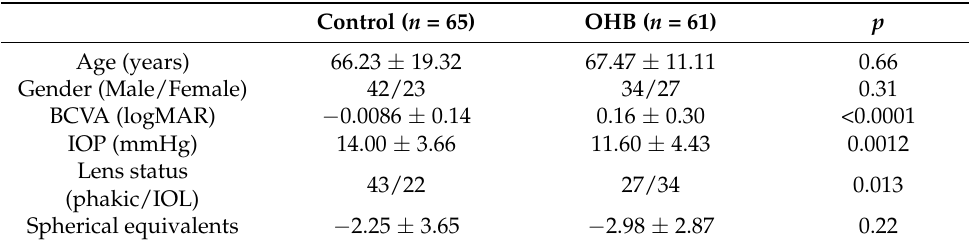
Table 1. Demographic data of participants included in the